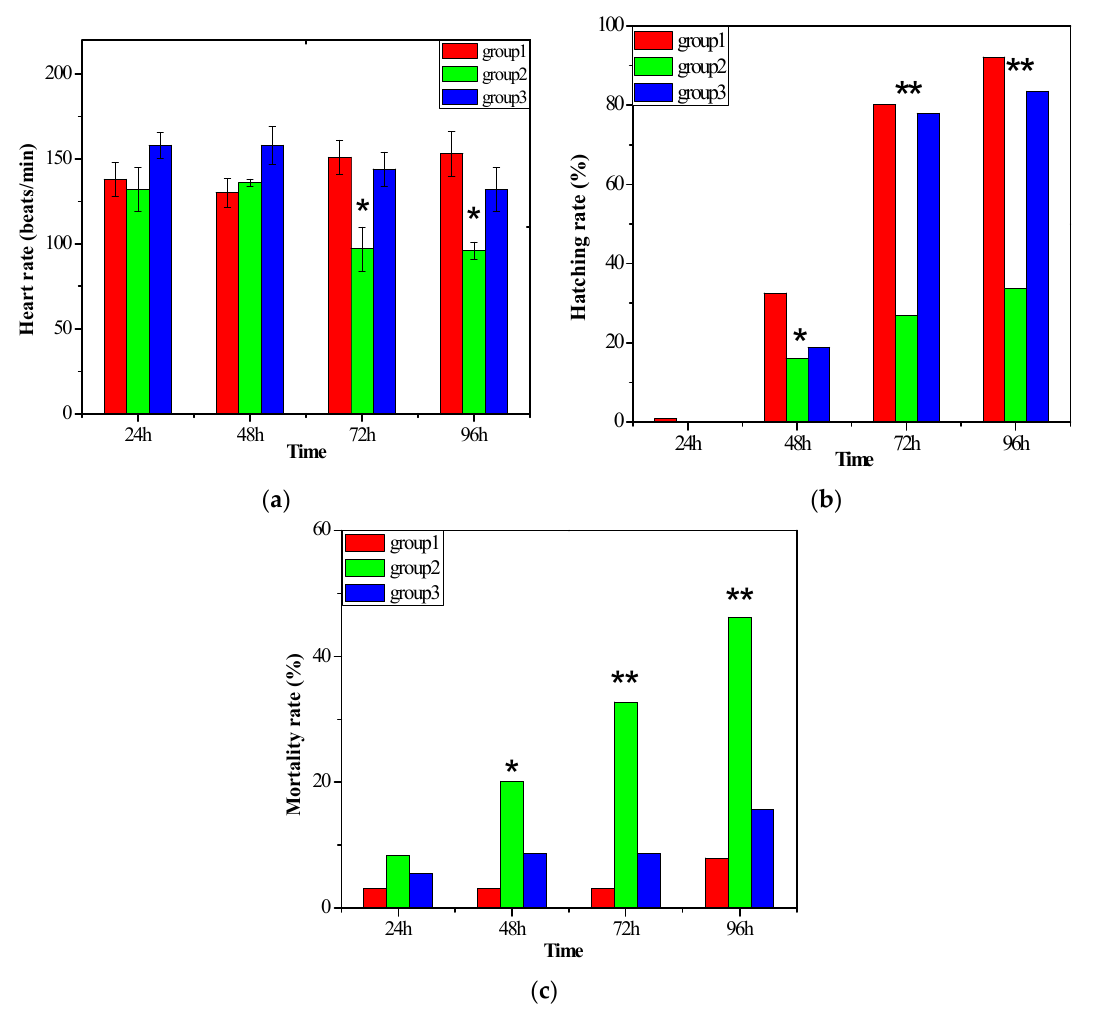
Figure 8. The heart rates ( a ), hatching rates ( b ), and mortality rates ( c ) of zebrafish embryos in three groups (* in each graph indicated significant differences, p < 0.05; ** in each graph indicated very significant differences, p < 0.005).